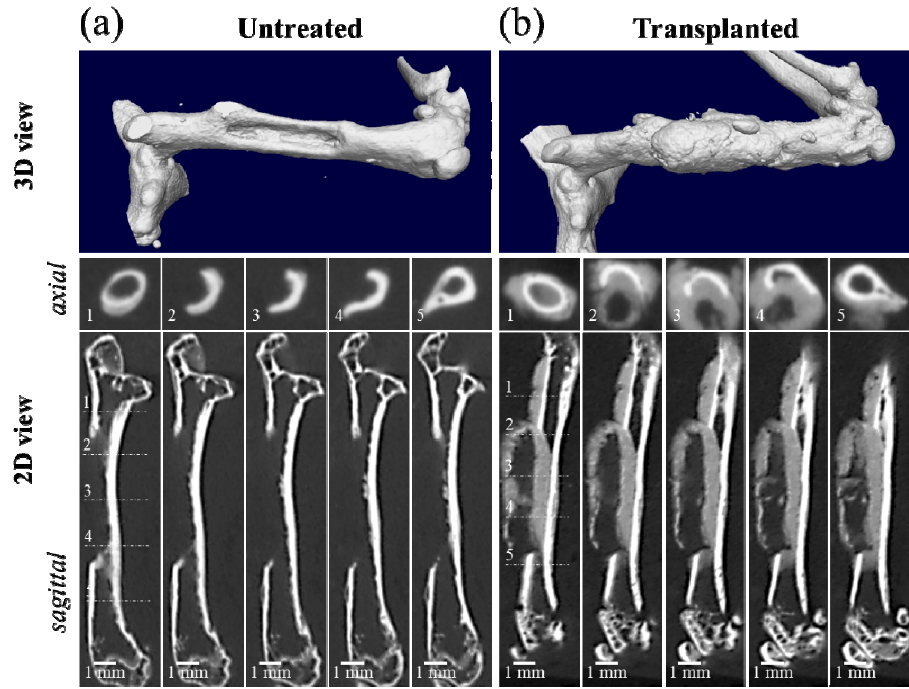
Figure 1. Micro-computed tomography ( µ CT) 3D view and a series of µ CT 2D radiological images of the axial and sagittal sections of a segmental bone defect 1 mm × 1 mm × 6 mm in size at the diaphysis of the left femur of a six-week-old male NOG / SCID mouse ( a ), and a follow up 21 days after nanogel cross-linked porous-freeze-dry (NanoCliP-FD) sca ff old transplantation into the bone defect ( b ). The numbers in the inset of the axial sections correspond to the respective numbers in the sagittal section.